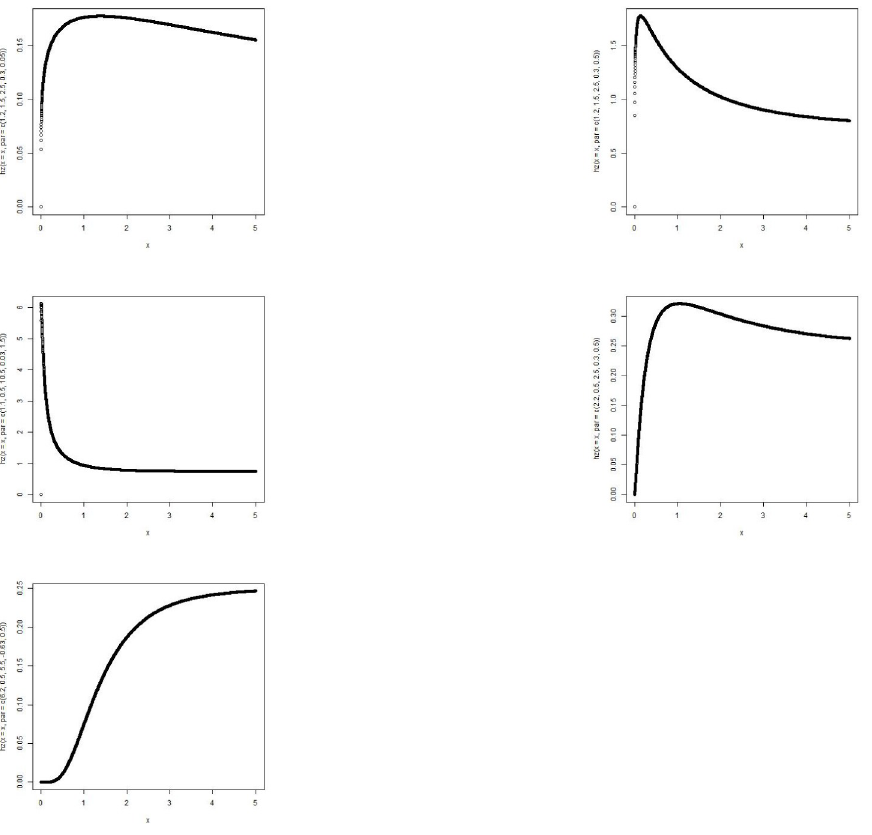
Fig 4. Graphs of hazard function of MBTED with various parameter